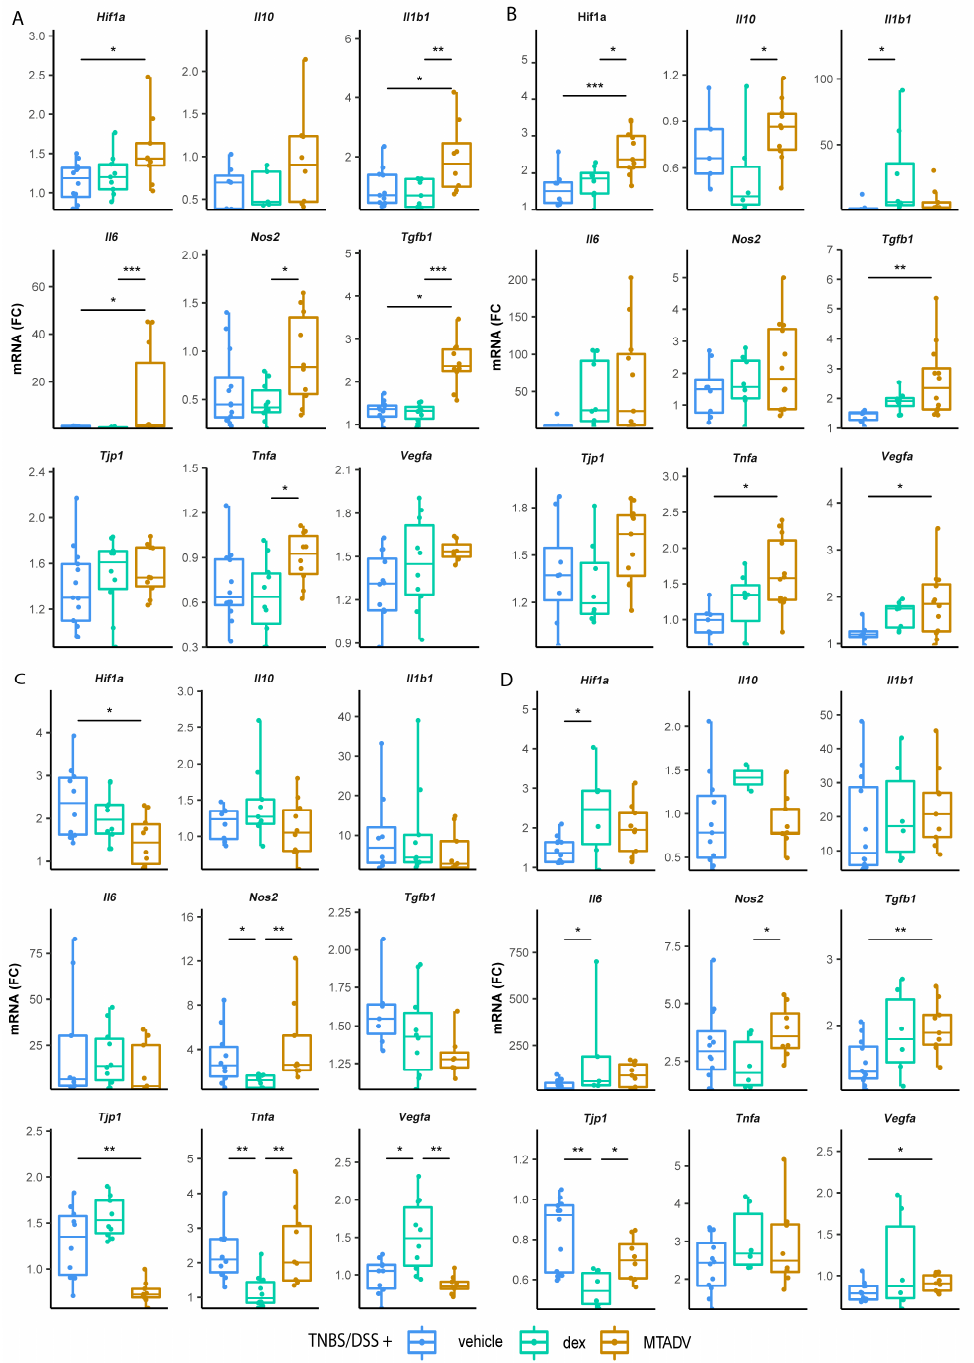
Figure 5. mRNA expression of inflammatory markers in each treatment group in the affected mucosa. qRT-PCR quantified mRNA expression as FC of inflammatory markers for both therapeutic and preventive trials from the TNBS (( A ) and ( B ), respectively)) and DSS models (( C ) and ( D ), respectively). Data are represented as points summarized in boxplots, indicating IQR, and bars, indicating maximum and minimum. The median point is depicted as a bar inside the box. Treatment groups are differentiated using colors. Asterisks mark significance between the groups indicated by lines (Kruskall–Wallis test with a posthoc Dunn’s test). Significance levels are: * p -value ≤ 0.05; ** p -value ≤ 0.01; *** p -value ≤ 0.001. Dex, dexamethasone; DSS, dextran sulphate sodium; FC, fold-change; IQR, interquartile range; MTADV, 5 ‐ MER peptide methionine ‐ threonine ‐ alanine ‐ aspartic acid ‐ valine; TNBS, trinitrobenzenesulfonic acid.